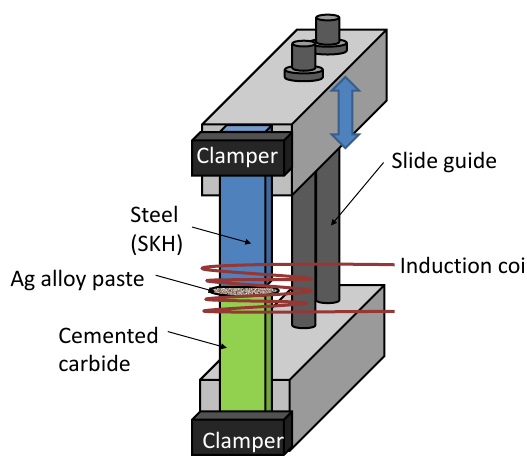
Figure 3. Butt-brazed specimen used in the present study.